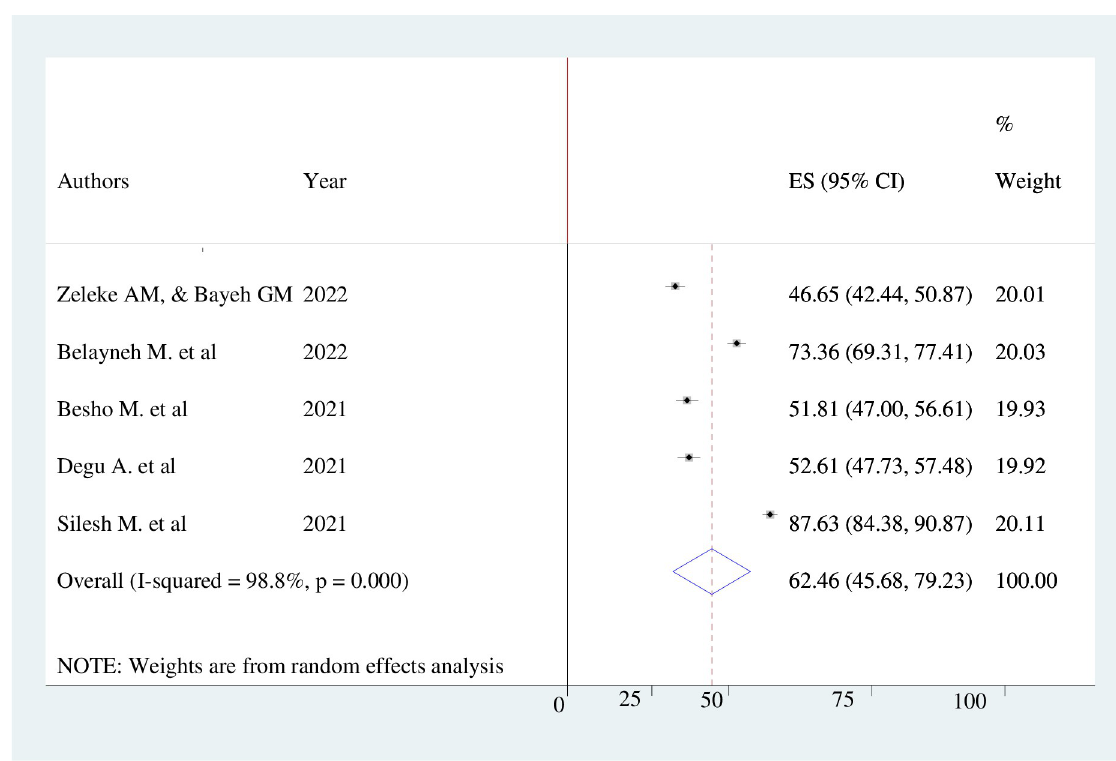
Fig 3. Pooled level of positive attitude of pregnant women’s towards COVID-19 infection